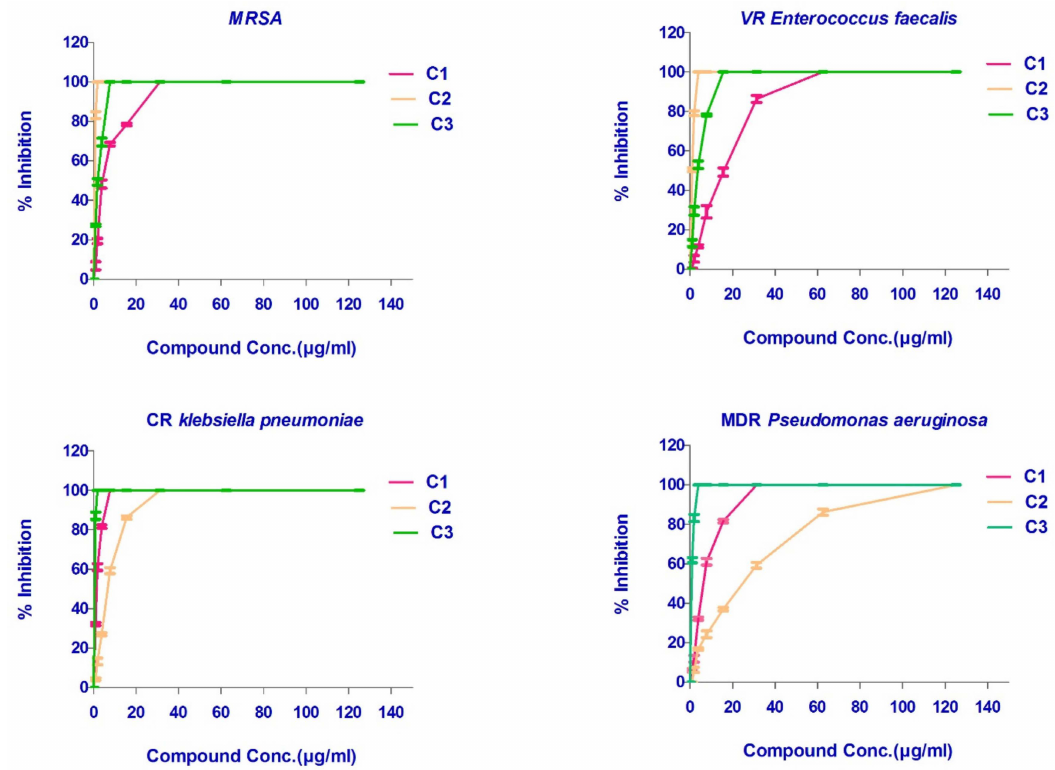
Figure 3. Inhibition % of the isolated compounds against different microbial resistance strains. All determinations were carried out in triplicate, and values are expressed as means ± SD.